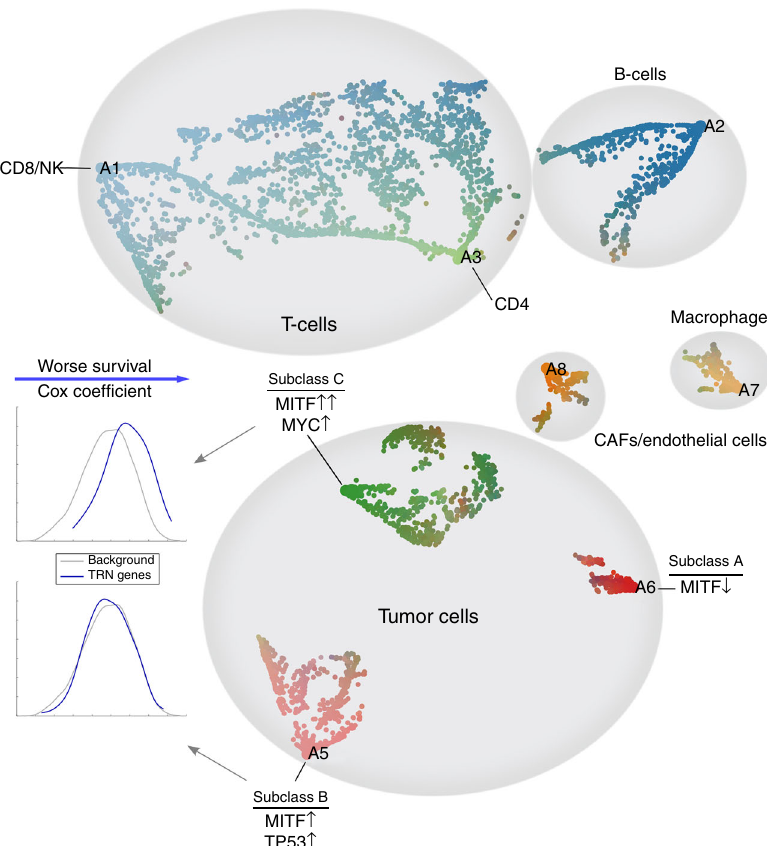
Fig. 6 A continuous view on the space of primary functions in the Melanoma dataset. Each archetype, representing a primary function, is illustrated using a textual label (A1 – A8). Each small dot represents a cell. Cells are color-coded based on their proximity to archetypes. All data points are projected onto a 2D plane using a carefully initialized Stochastic Neighbor Embedding method (SNE, see Supplementary Note 10). The functional space of cells exhibit a mix of cell state continuum, such as in the case of T-cells, as well as discrete cell types. Three subclasses of melanoma tumor cells are marked accordingly in the map. Subclasses B and C are both MITF-associated. Among them, genes that participate in the transcriptional regulatory network (TRN) for subclass B do not show any signi fi cant shift in Cox coef fi cient, compared to the background of all genes, whereas in subclass C they do. In this sense, high-expression of genes in the TRN of subclass C is signi fi cantly associated with worse outcome in the melanoma